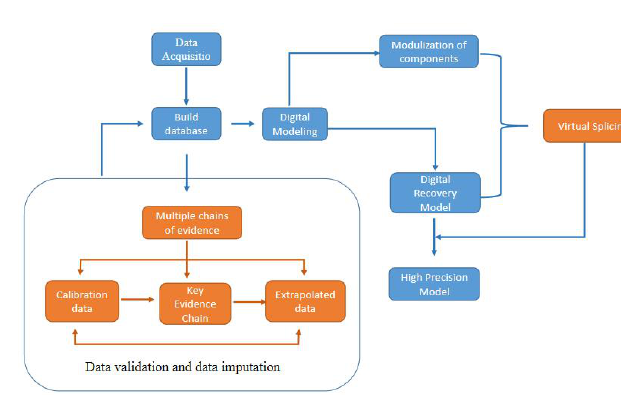
Figure 5. High-precision Digital Restoration Flow